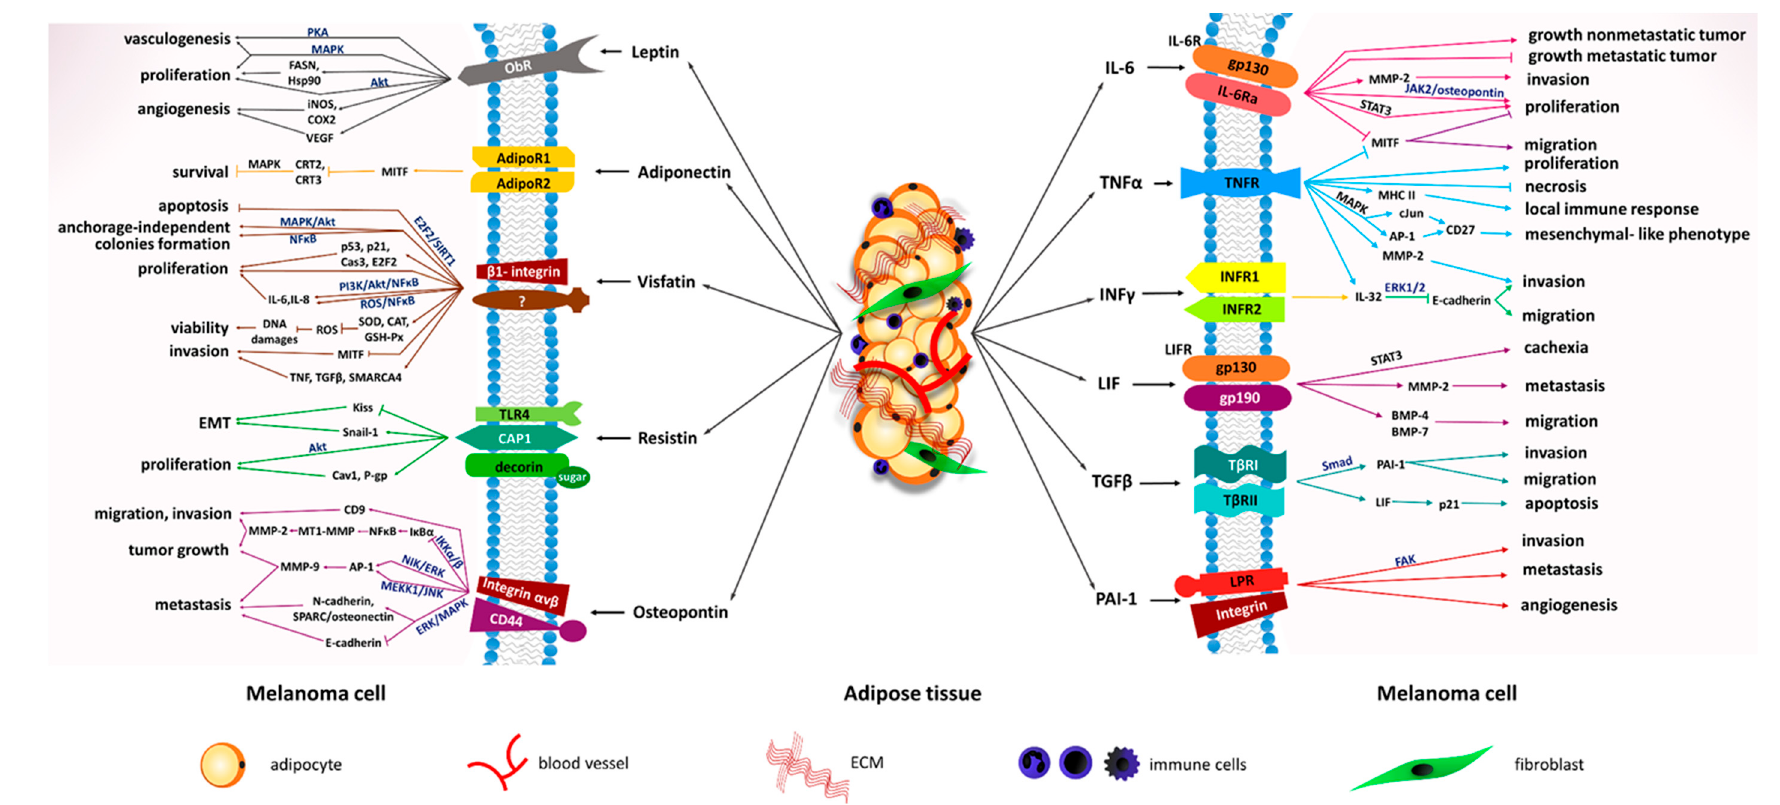
Figure 2. The effect of molecules released by adipose tissue on melanoma cells. Adipocytes secreted factors that interact with their receptors and affect tumor progression via